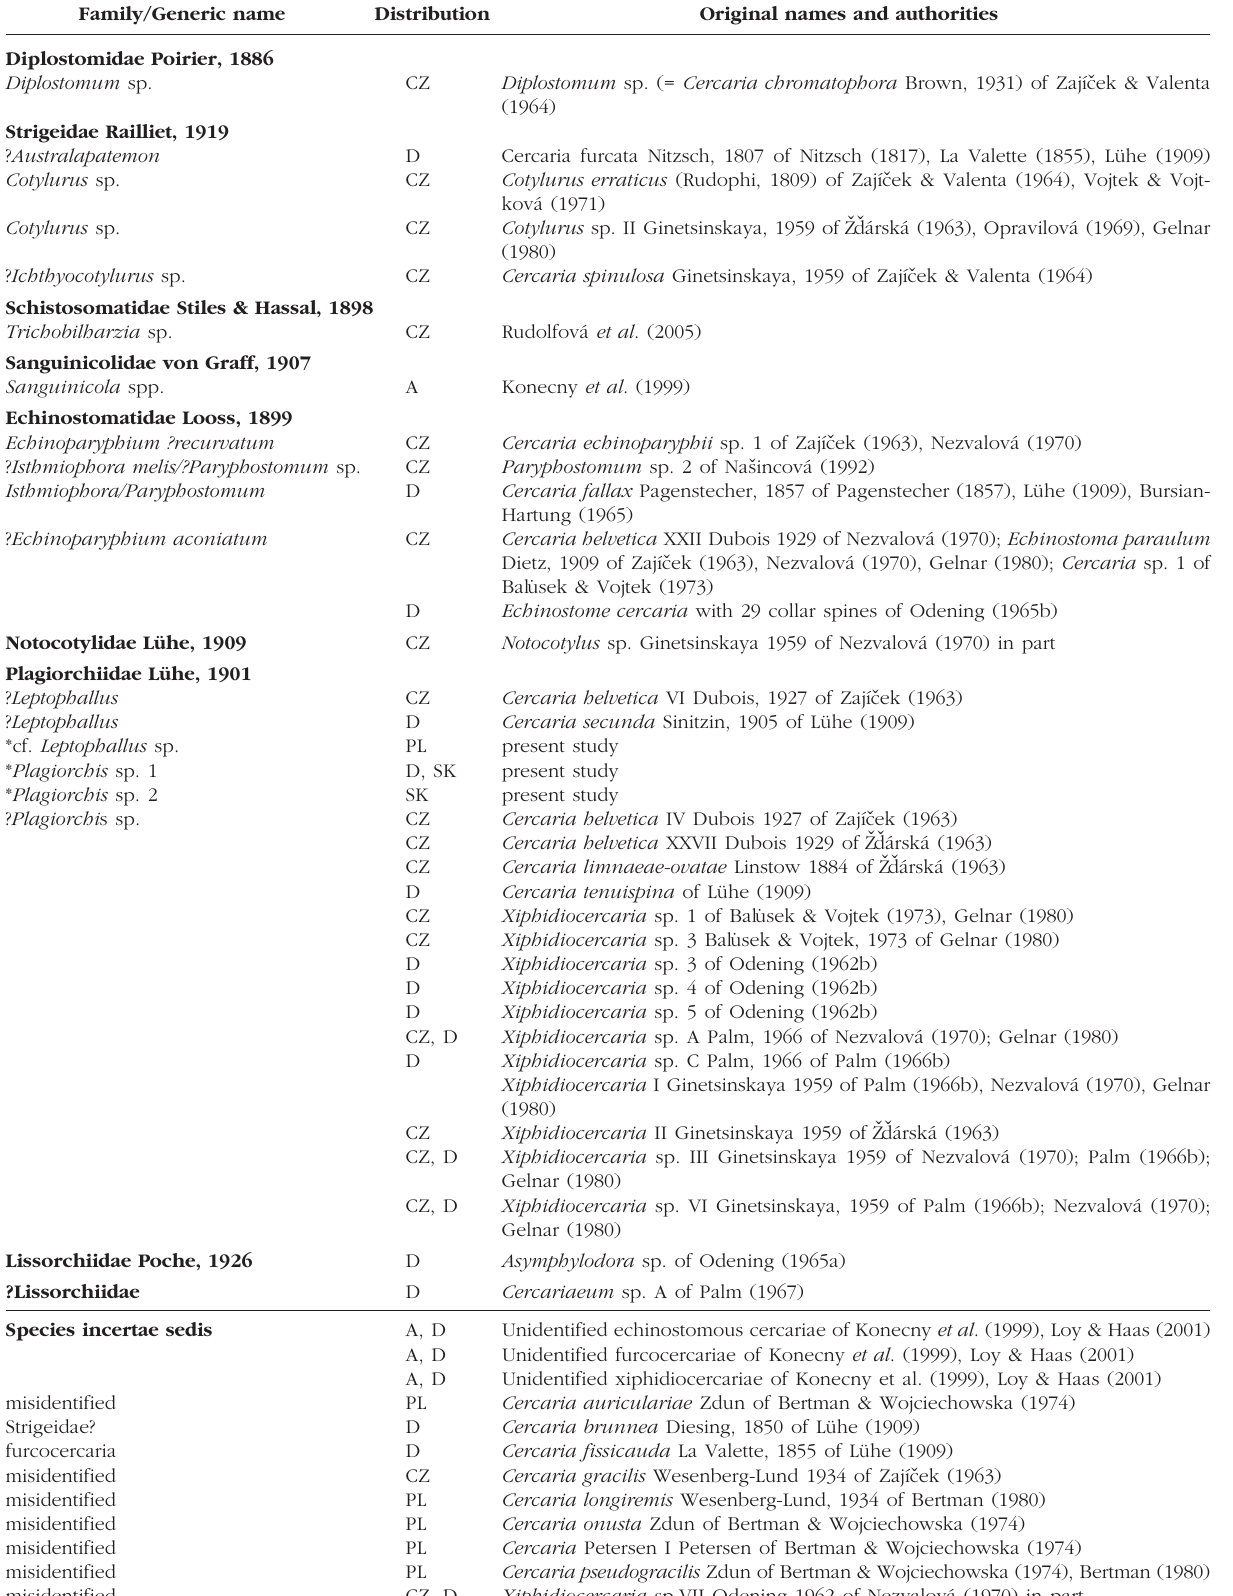
Table III – Survey of species of cercariae identifited to genus or with provisional names reported from Lymnaea stagnalis in